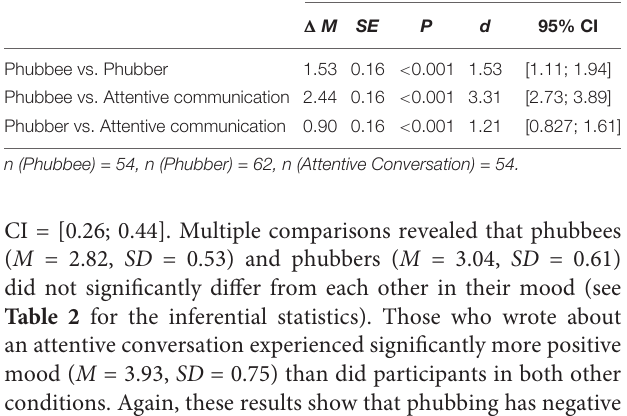
TABLE 3 | Phubbing effects on reported feelings of being ignored and excluded multiple comparisons between experimental conditions. Feeling ignored and excluded (cid:49) M SE P d 95%